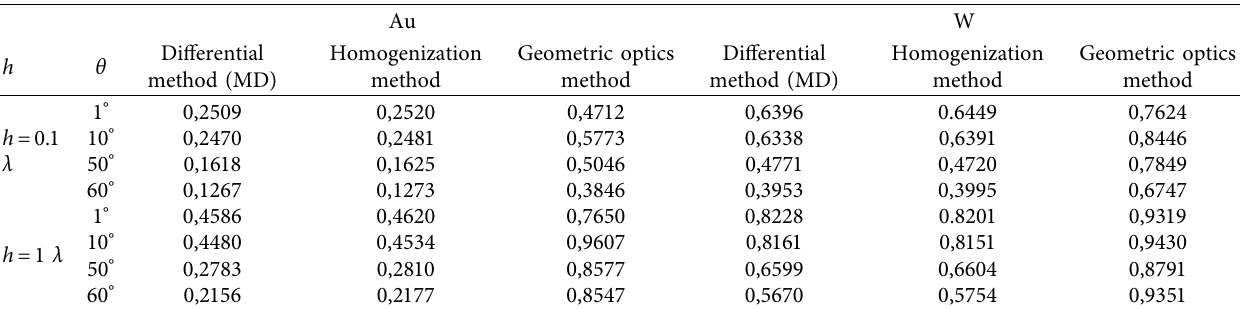
Table 1: Comparison between the emissivity calculated by the homogenization process and those calculated by the differential and geometric optics methods for λ equal to 0.05, in the case of TE polarization. Case of the sinusoidal-shaped surface.